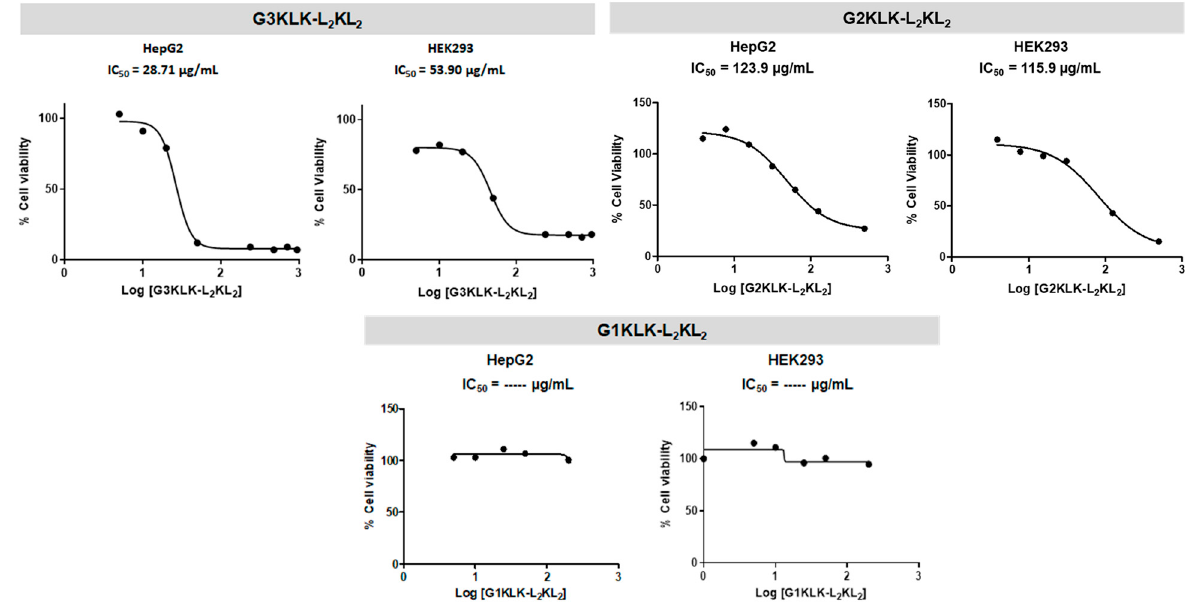
Figure 2. Cytotoxicity of G3KLK-L 2 KL 2 , G3KLK-L 2 KL 2 and G3KLK-L 2 KL 2 in HepG2 and HEK293 cell lines.